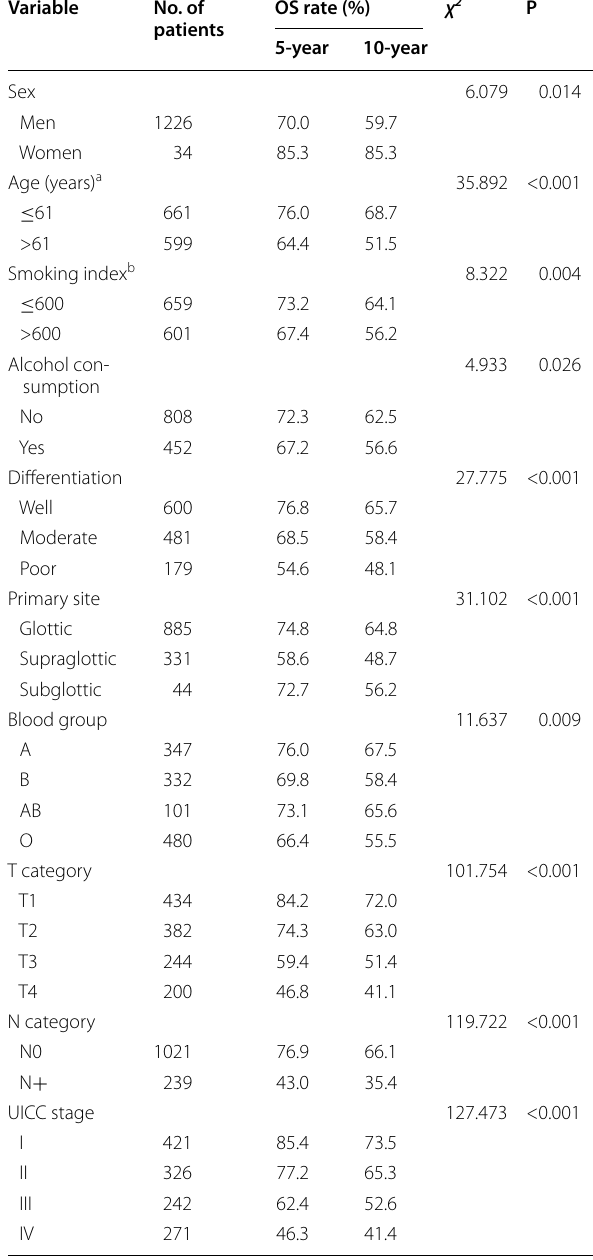
Table 2 Univariate prognostic analysis for overall survival (OS) rates of 1260 patients with laryngeal cancer